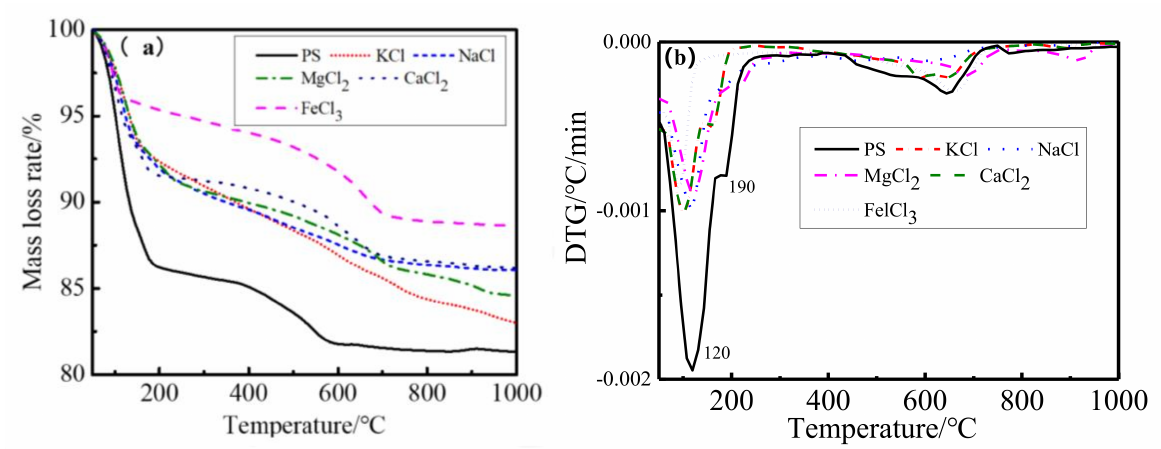
Figure 8. TG/DTG of modified PS samples. ( a ) TG results, ( b ) DTG